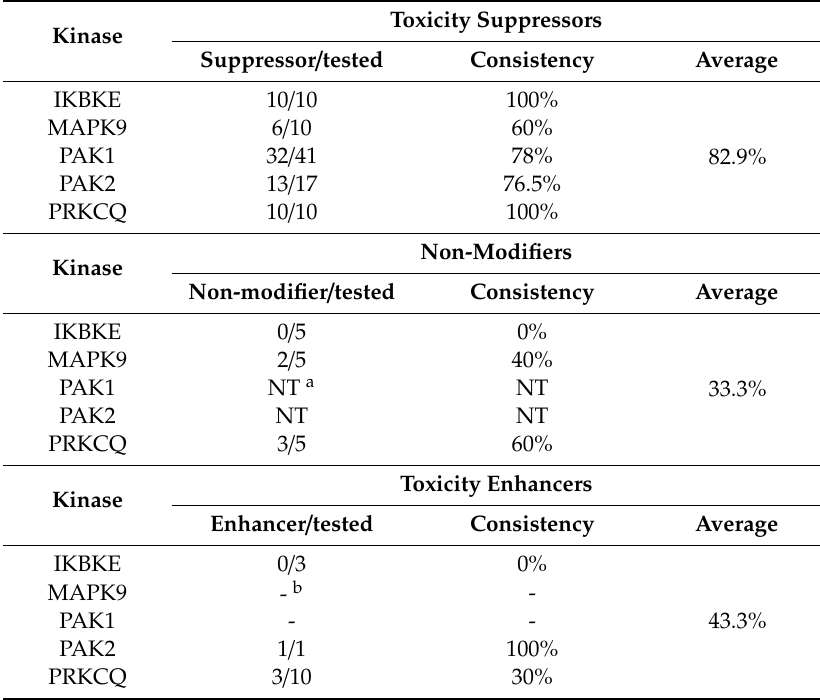
Table 2. Summary of the results of yeast spotting